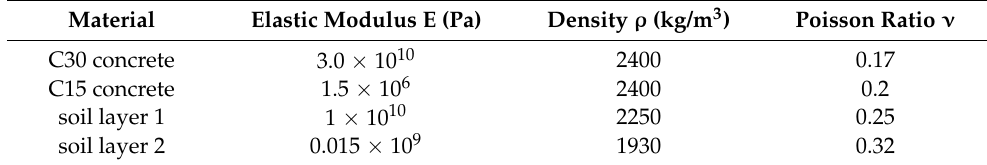
Table 4. Material parameter